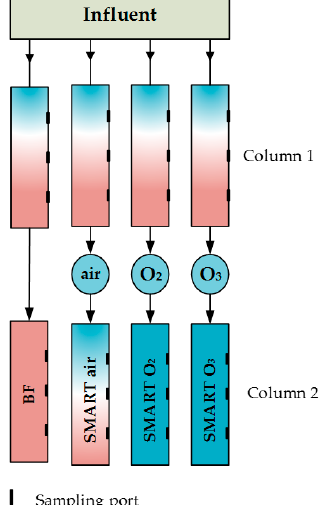
Figure 1. Conceptual design of the laboratory-scale soil column set-up (h = 1.00 m, ID = 0.14 m; HRT ≈ 6 days).